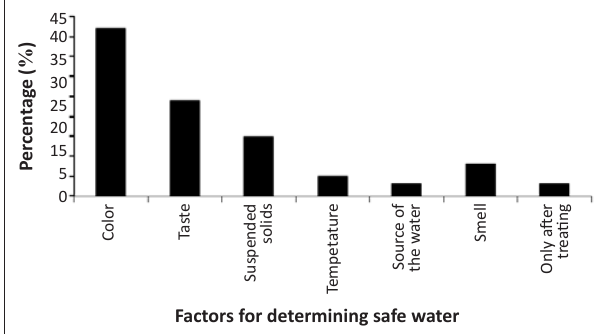
FIGURE 6 : Factors used by respondents to determine safe drinking water.